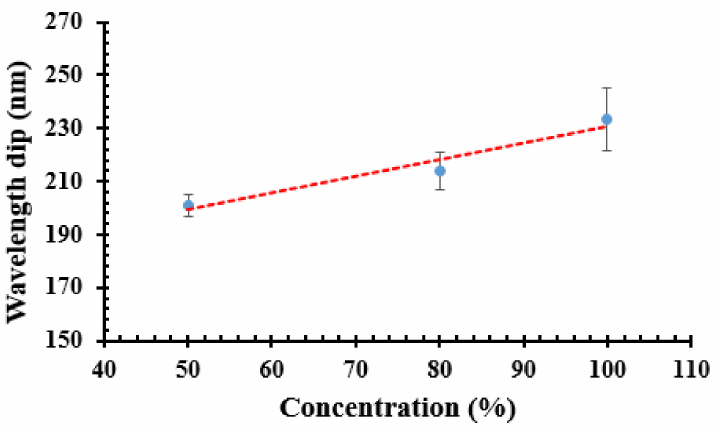
Figure 9. Sensitivities of the fabricated